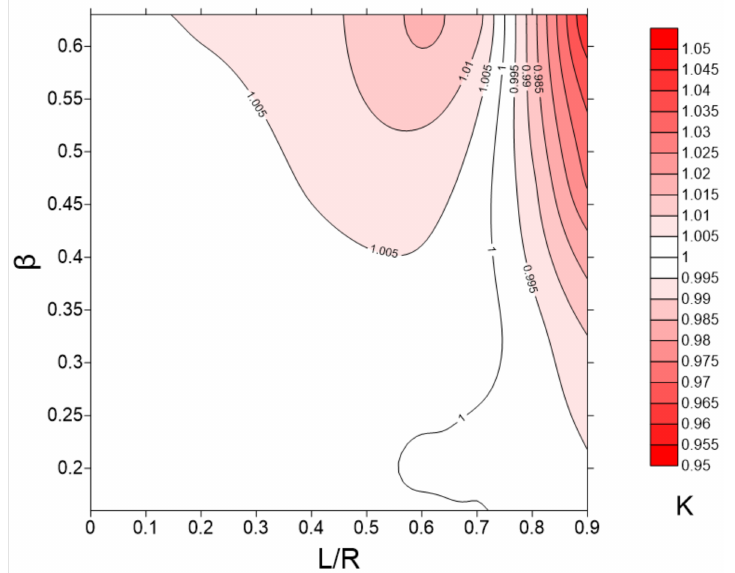
Figure 8. Dependence of K at the chord on the distance L to the section center and the relative amplitude of pulsations β